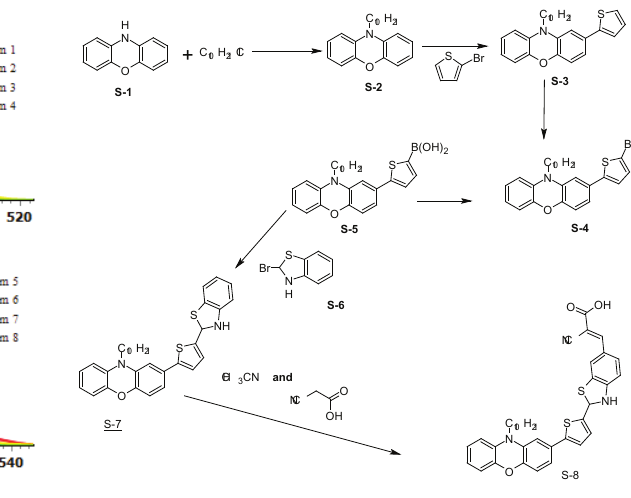
Figure 4: Simulated Absorption spectra of the designed systems. Scheme: Multistep synthesis scheme of